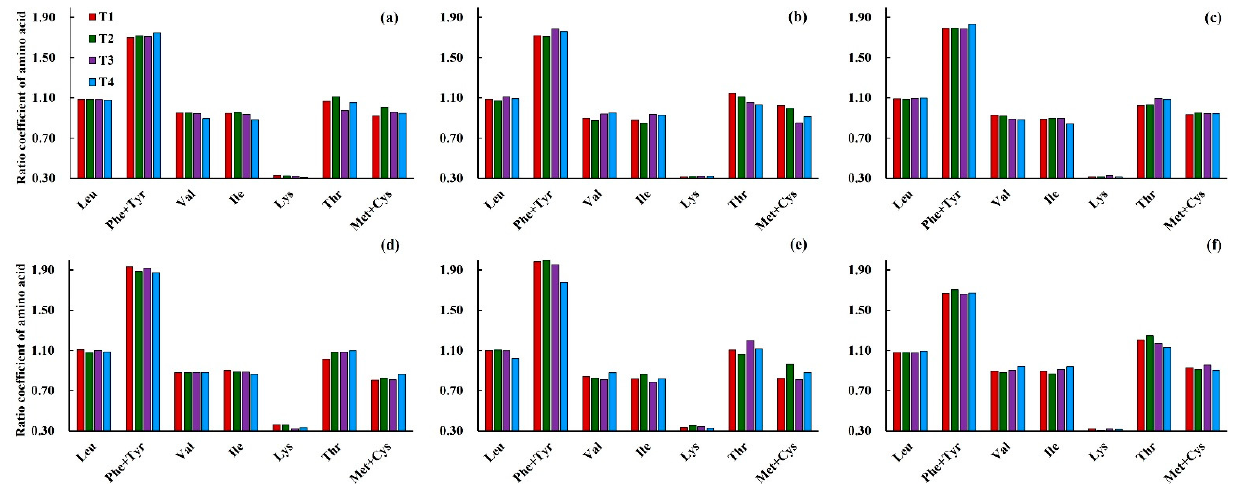
Figure 7. Effects of different low-temperature intensities and stages on the ratio coefficient of amino acids for Yangmai16 ( a – c ) and Xumai30 ( d – f ). ( a , d ) jointing stage; ( b , e ) booting stage; ( c , f ) jointing and booting stages.